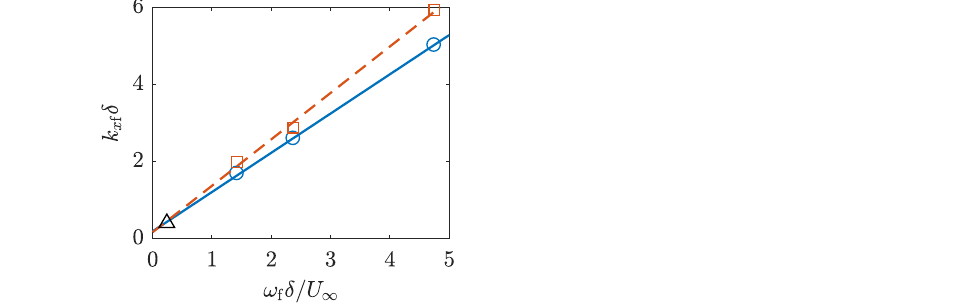
Figure 6. Streamwise wavenumber of the synthetic mode, k x f , plotted against angular forcing frequency, ω f , for actuation amplitude h rms / δ = 0.042: (cid:13) RW-DRF data; — RW-DRF linear fit, k x f δ = 1.10 ω f δ / U ∞ + 0.18; (cid:3) CW-DRF data; – – CW-DRF linear fit, k x f δ = 1.20 ω f δ / U ∞ + 0.17; (cid:52) Duvvuri and McKeon